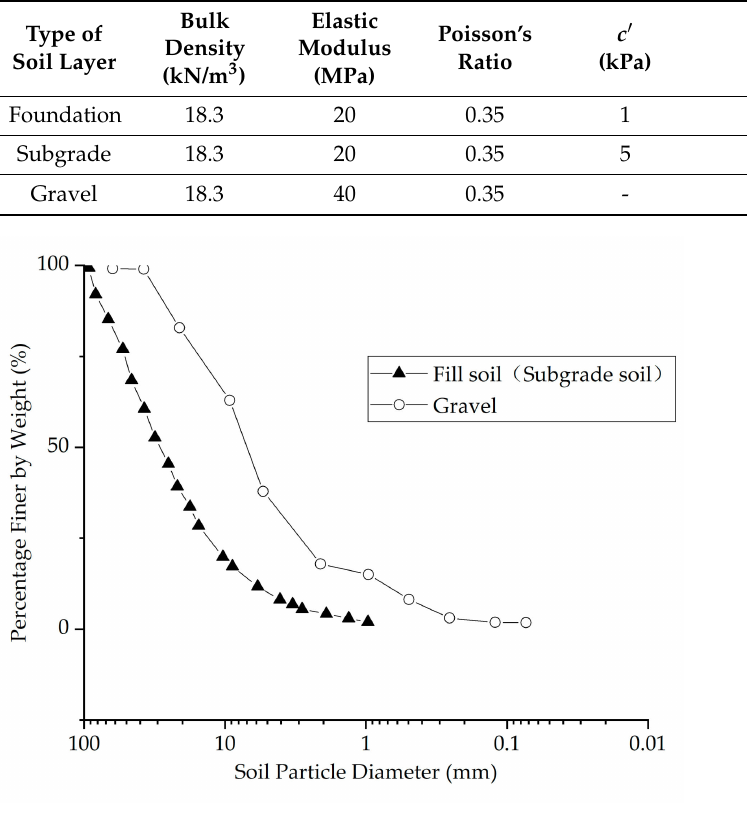
Figure 4. Grain size distribution of the